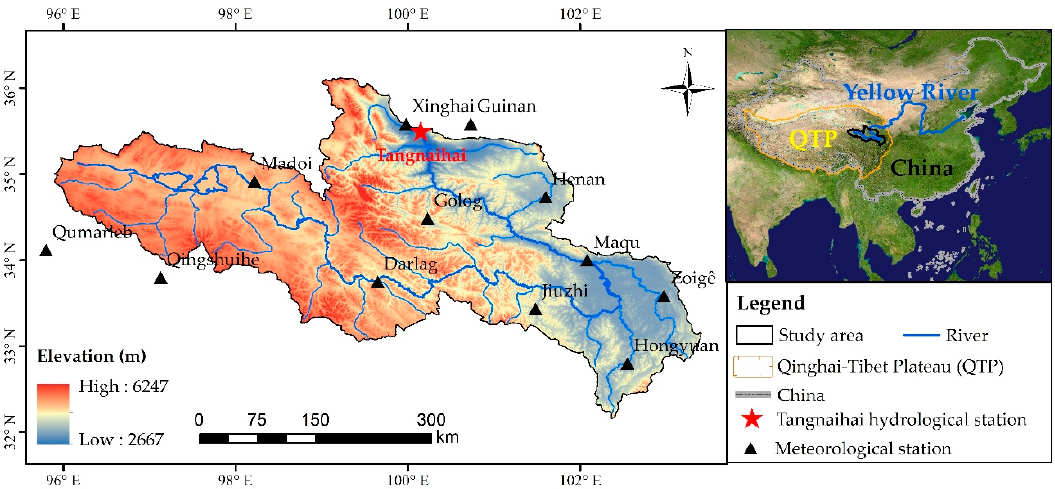
Figure 1. Geographical location of the source region of the Yellow River Basin and hydro-climatic stations settled in the area.